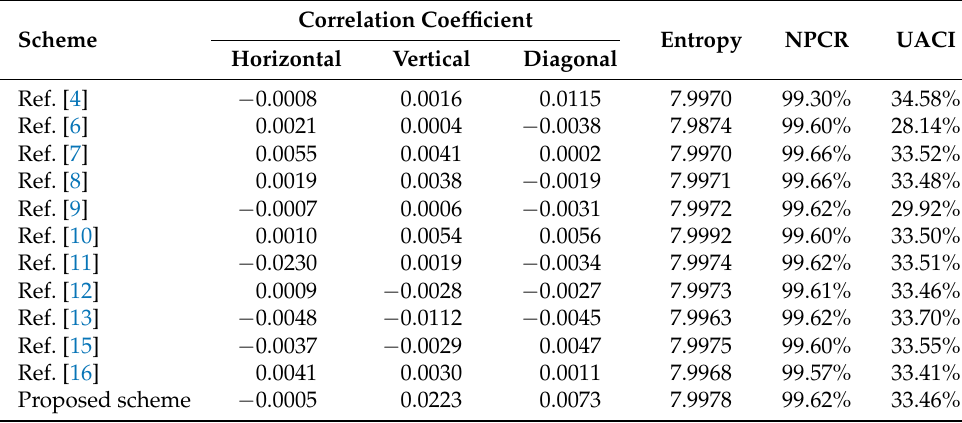
Table 11. Comparison with existing